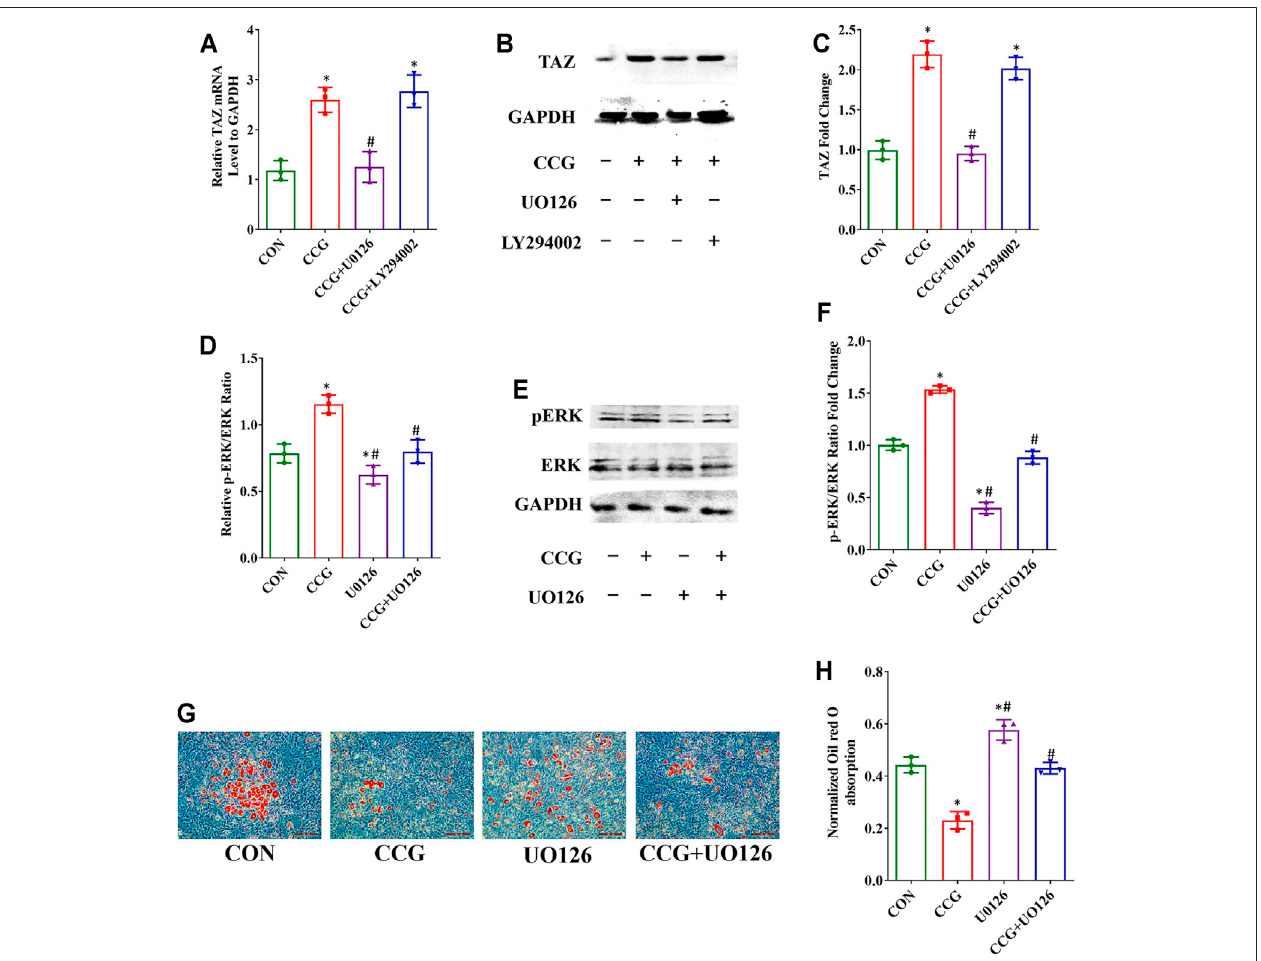
FIGURE 6 | Decreased adipogenic differentiation accompanied by increased TAZ expression was also mediated by p-ERK/ERK signaling after CCG treatment. (A – C) Relative mRNA and protein levels of TAZ to GAPDH at Day 3 after the treatment during adipogenesis. (D – F) Relative mRNA and protein levels of p-ERK at Day 3 after the treatment during adipogenesis. (G, H) Representative images ofOil Red O staining showed the lipid droplets were lessened by CCG. Scale bar: 100 μ m (n (cid:1) 3) * p < 0.05 vs. the control group (cells cultured in adipogenic medium during adipogenesis); # p < 0.05 vs. the CCG treatment group.